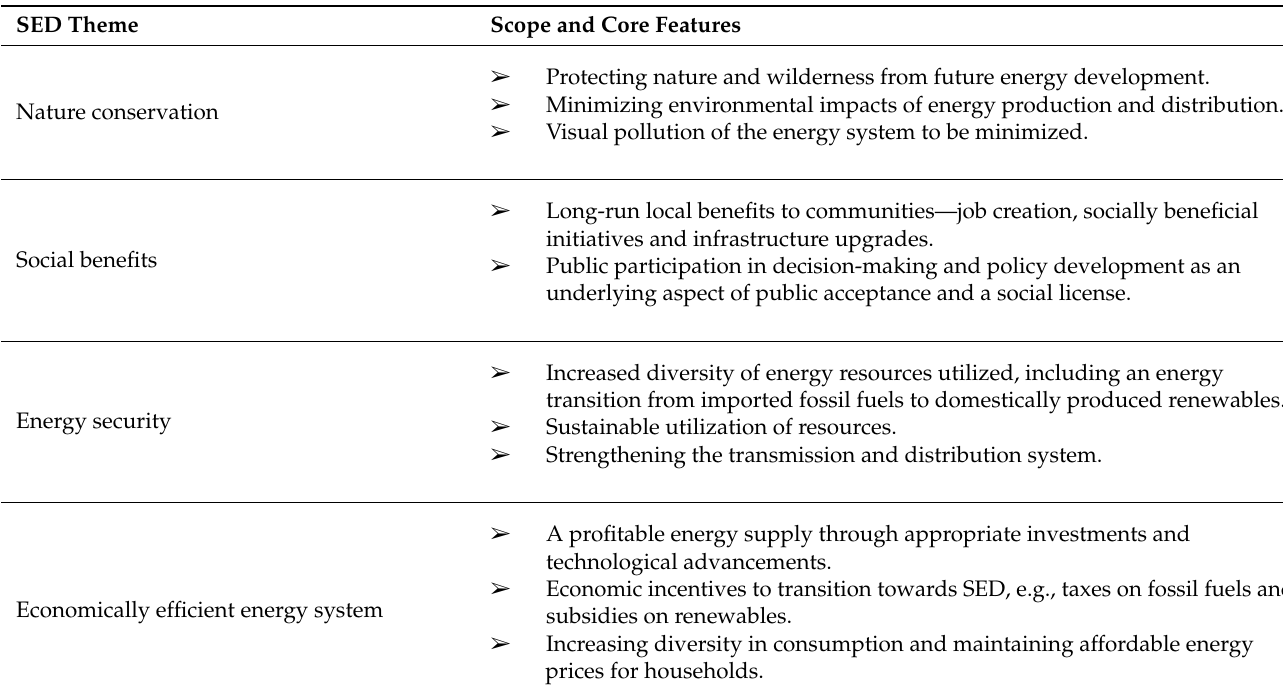
Table 1. SED themes in Iceland and respective scope (adapted with permission from